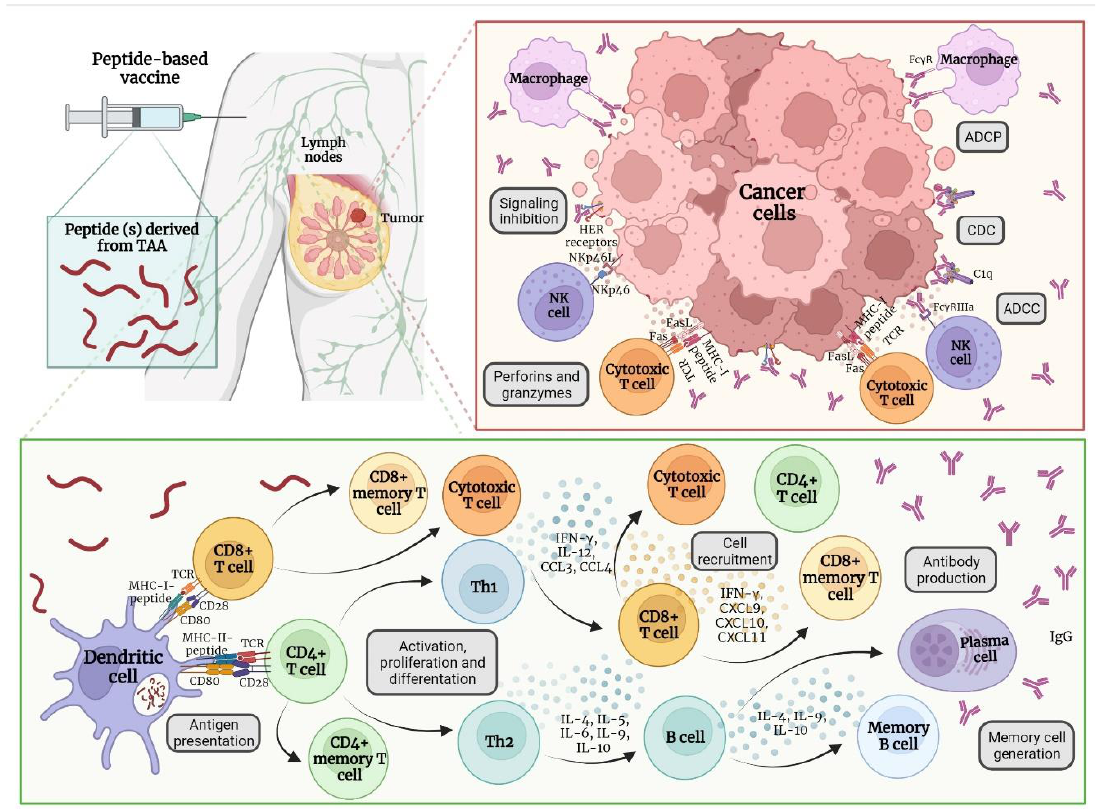
Figure 2. Immunological mechanism of action of the peptide-based vaccines. After its administration, the peptides will be recognized by innate immune cells that promote the activation of the adaptive immune response (cellular and humoral). Released antibodies can promote the destruction of tumoral cells by ADCC, CDC, ADCP, signaling inhibition, and complement activation (classical pathway), whereas cytotoxic T cells can promote apoptosis of cancer cells by releasing perforins and granzymes or by interacting with Fas/FasL. APC: antigen-presenting cell; MHC-I: major histocompatibility complex type I; MHC-II: major histocompatibility complex type II; Th1: T helper 1; Th2: T helper 2; ADCC: antibody-dependent cellular cytotoxicity; CDC: complement-dependent cytotoxicity; ADCP: antibody-dependent cellular phagocytosis. Image created in Biorender (https://biorender.com/ accessed on 2 July 2022).